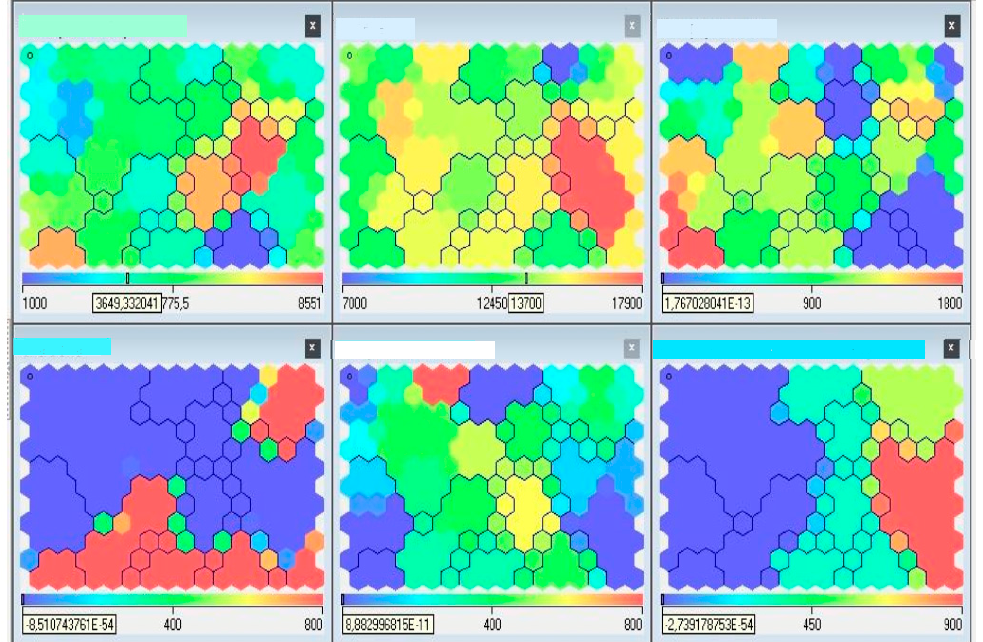
Figure 5. Characteristics of financial income in the form of two-dimensional Kohonen maps.